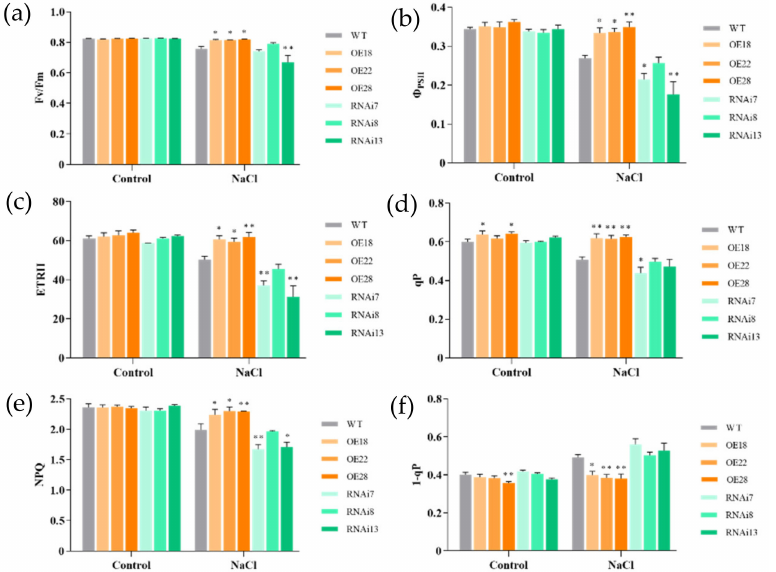
Figure 5. Effects of NaCl treatment on chlorophyll fluorescence parameters of wild-type (WT), overexpression (OE18, OE22, and OE28), and RNAi lines (RNAi7, RNAi8, and RNAi13). ( a ) Maximum quantum yield (Fv/Fm), ( b ) effective quantum yield of PSII ( Φ PSII ), ( c ) electron transport rate of PSII (ETRII), ( d ) photochemical quenching (qP), ( e ) non-photochemical quenching (NPQ), and ( f ) redox state of the Q A electron acceptor of PSII (1-qP) in dark-adapted seedlings for 30 min after 6 d of salt treatment. The experiment was repeated three times, and each treatment included four replications. Data are means ± SE ( n = 4). An asterisk indicates a significant difference (LSD test, * p < 0.05 and ** p < 0.01) between wild-type, overexpression, and RNAi